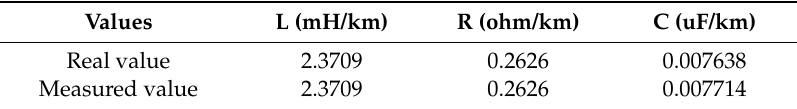
Table 1. The real values and measured values on grounding electrode